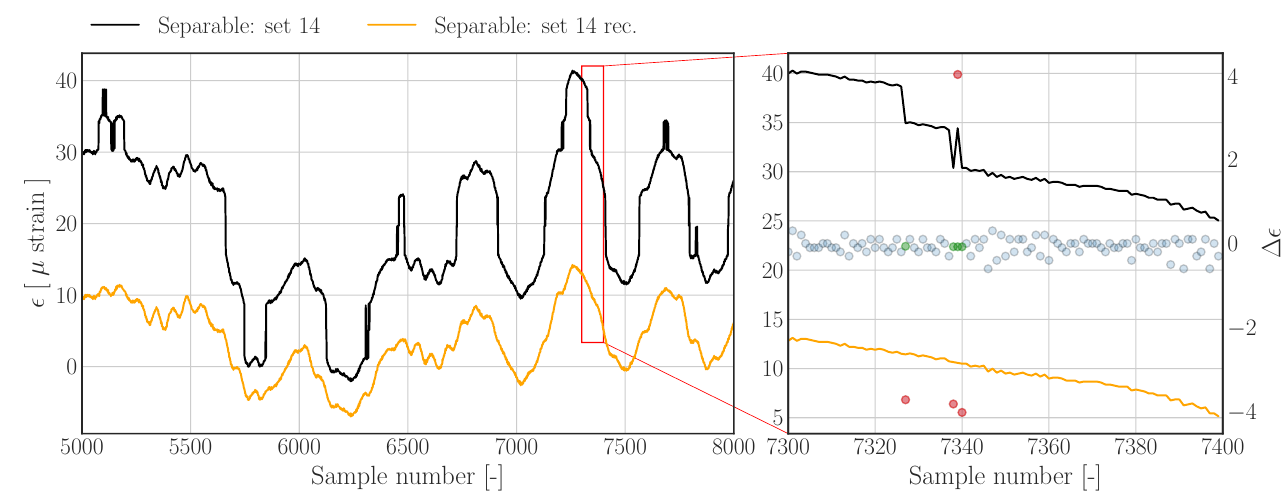
Figure 10. Left : Subset of data set 14 from Separable.hdf5 (dashed), and reconstructions (solid) using the Hampel filter based method . Right : Zoom in on region containing jumps. Nominal difference samples are indicated with blue dots, outliers and corresponding outlier replacements are indicated by red and green dots, respectively.